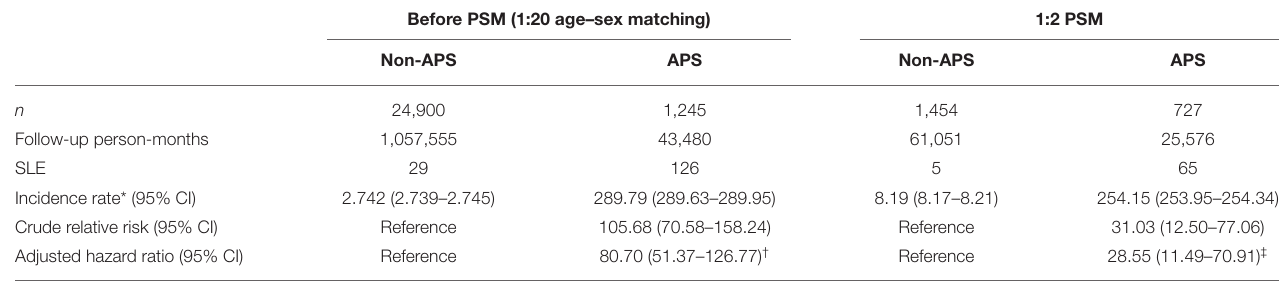
TABLE 2 | Incidence of SLE in the study groups before and after